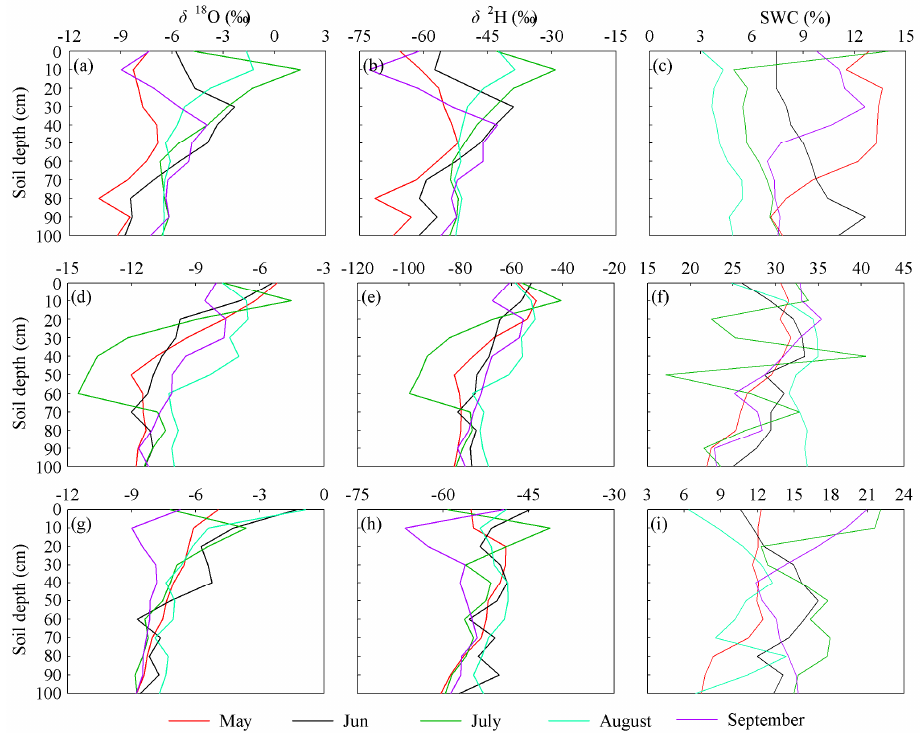
Figure 3. Mean δ 18 O, δ 2 H, and soil water content (SWC) for soil water at a depth of 0-100 cm in Gulang ( a , b , c ), Wushaoling ( d , e , f ) and Tianzhu ( g , h , i ).